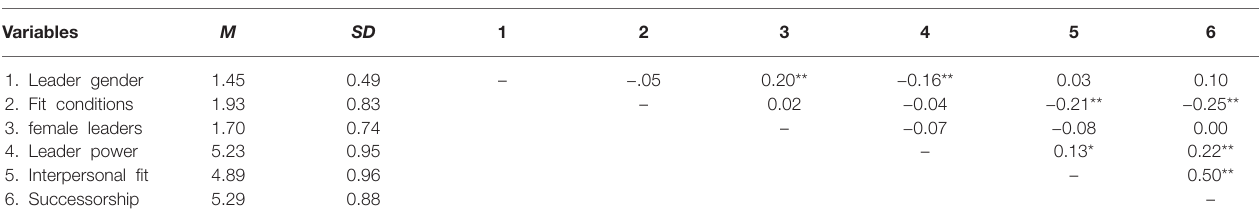
TABLE 2 | Descriptive statistics and Pearson zero-order correlations (study 2).